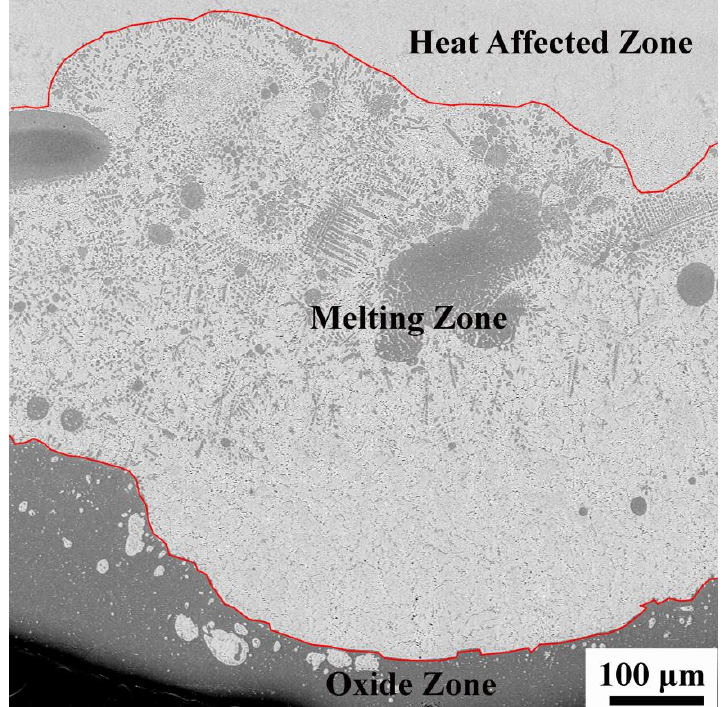
Figure 8. SEM of combustion area of titanium alloys, reproduced from [69] with permission from Shao, L. et al., 2016.